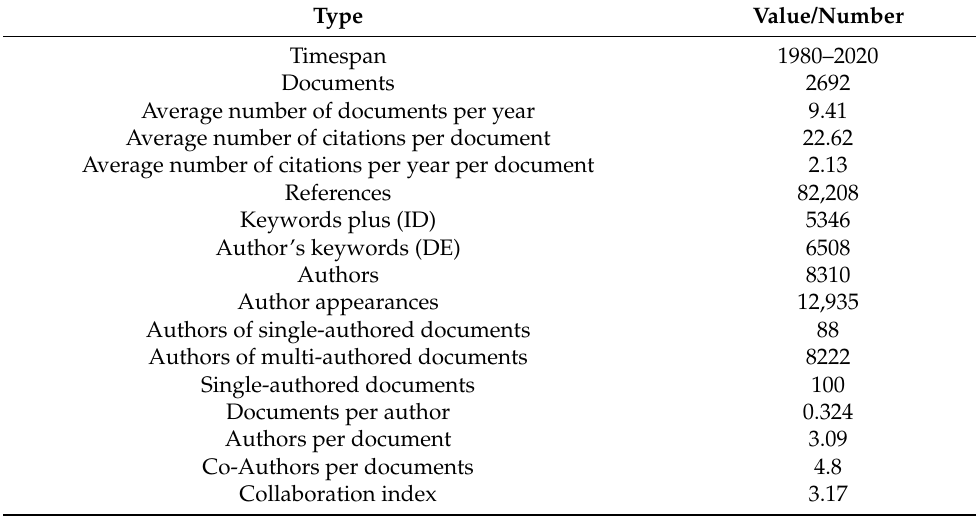
Table 1. Basic information of